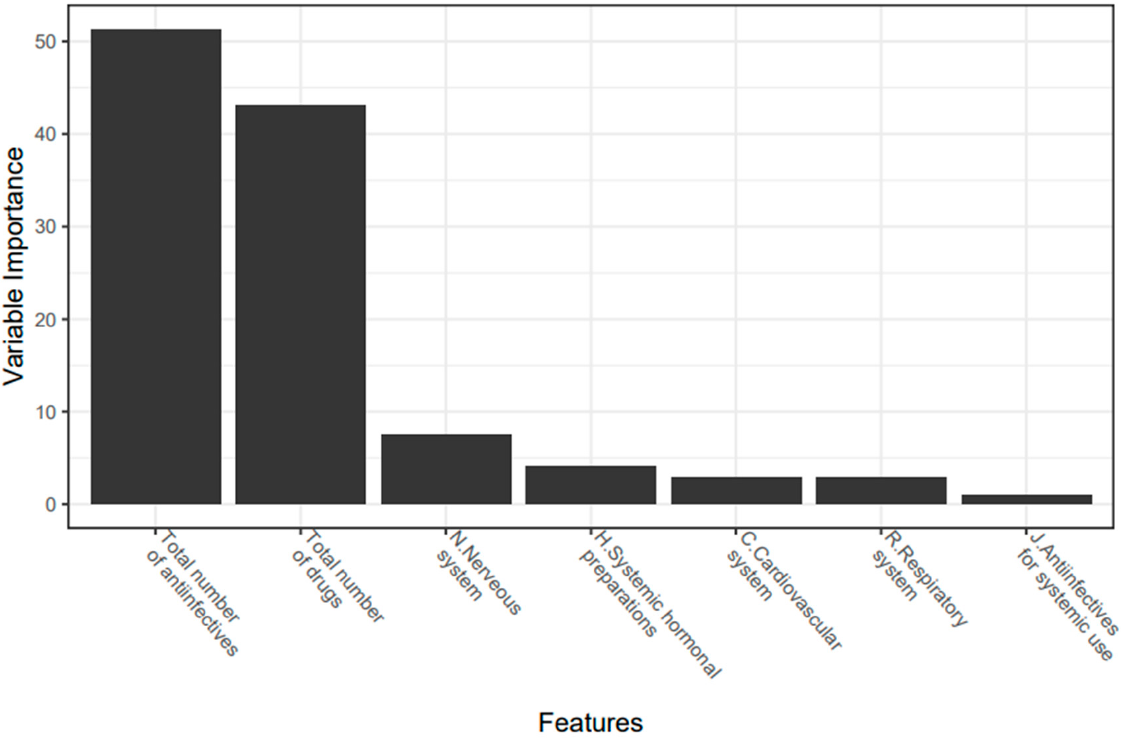
Figure 2. Variable importance plot (%) used to predict the presence of clinically relevant DDI. The obtained model showed very high performance in predicting the presence of DDI. Performance measurements of the model were as follows: accuracy 0.944 (95% CI 0.888–0.972), sensitivity 0.892 (95% CI 0.769–0.962), selectivity 0.966 (95% CI 0.913–0.991),